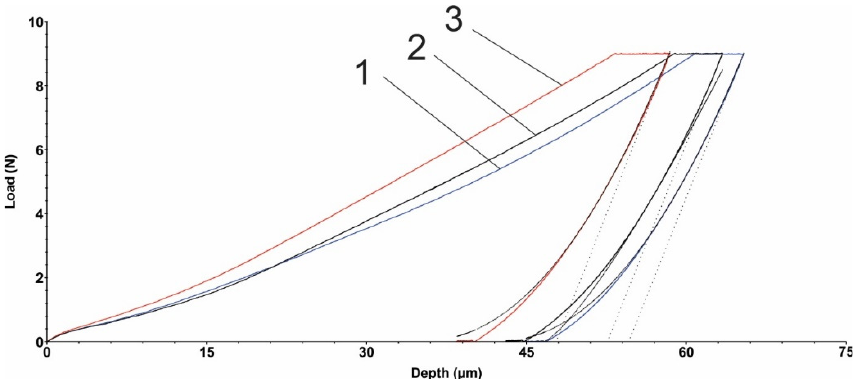
Figure 5. Hexagonal texture microindentation test (2 passes): 1, 2, 3—measurements.